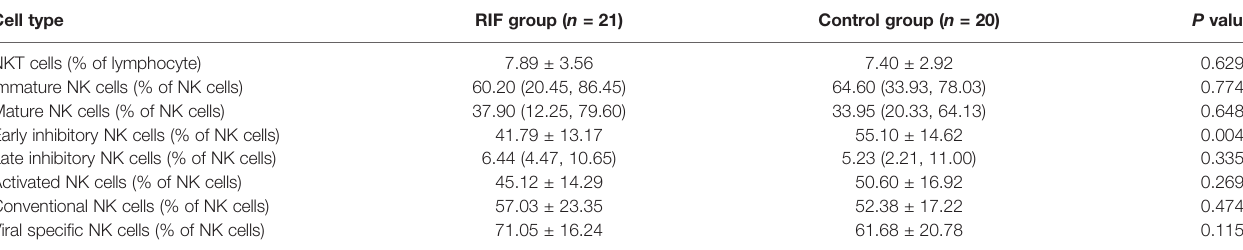
Figure 1A ), a higher percentage of Tfh1 cells (11.70 ± 3.34 vs. 9.58 ± 2.33; P < 0.05; Figure 1B ), a lower percentage of Tfh2 cells (37.72 ± 6.57 vs. 42.72 ± 4.56; P < 0.05; Figure 1B ), a higher percentage of The Th17 cells (6.52 ± 2.45 vs. 4.42 ± 1.82; P < 0.05; Figure 1C ), and a lower percentage of the early inhibitory NK cells (41.79 ± 13.17 vs. 55.10 ± 14.62; P < 0.05; Figure 1D ), compared with the control group.